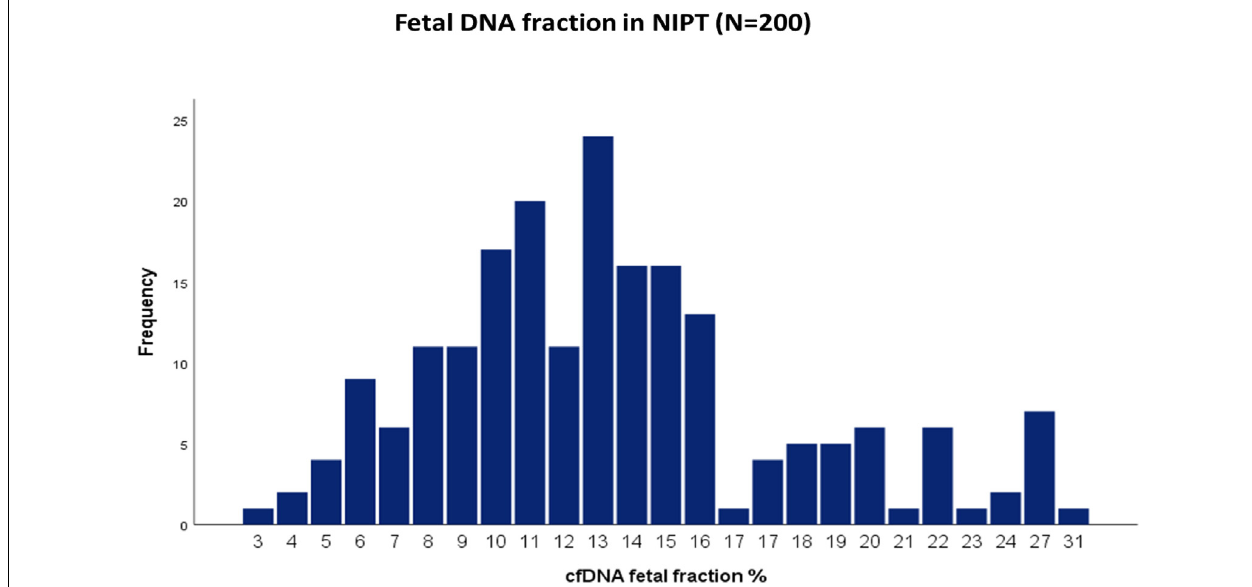
FIGURE 1 | Distribution of cfDNA fetal fraction percentage of all the 200 NIPT cases.